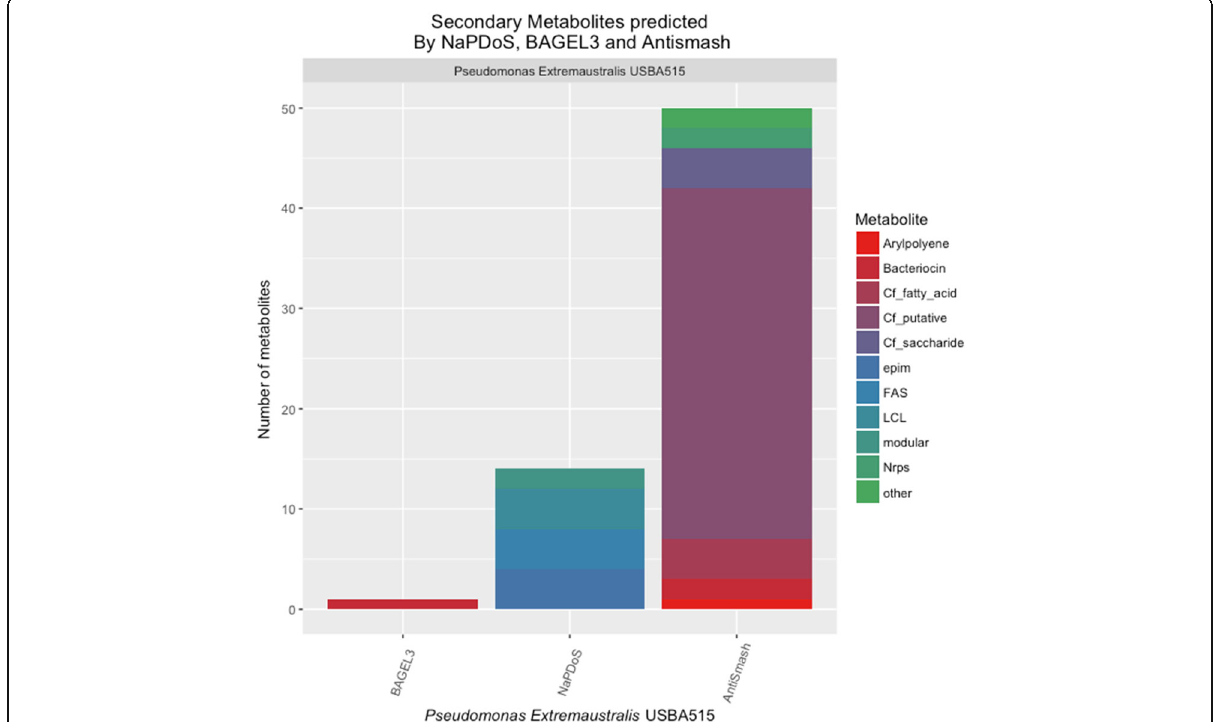
Fig. 4 Secondary metabolites predicted by antiSMASH 3.0 [71], BAGEL3 [35] and NaPDoS [36] softwares in the genome of Pseudomonas extremaustralis strain